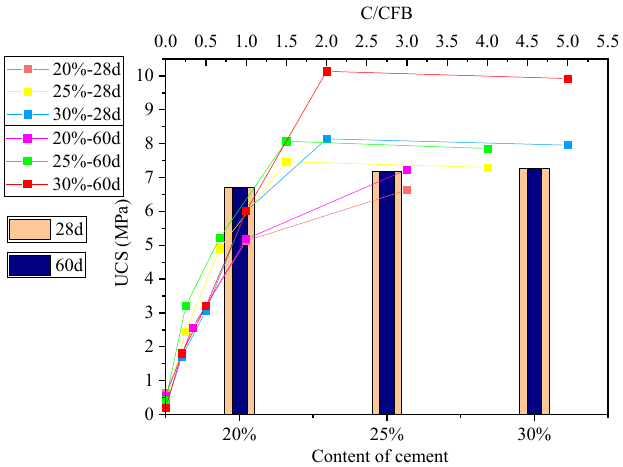
Figure 7. UCS curve of cement-stabilised soil admixed with CFB-BA for 28 days and 60 days (bar graph shows strength of cement-stabilised soil). C/CFB indicates the ratio of cement to CFB-BA.